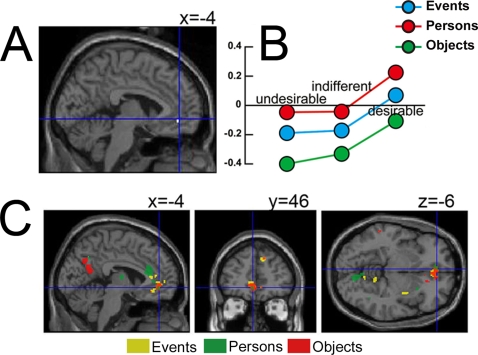
Conjunction analysis of desirable > undesirable (displayed at the threshold Puncorrected <0.001).Peak activity was located in superior orbito-frontal cortex (−4, 46, −6 SVC) and is shown in sagittal section (A). Parameter estimates for the three stimulus categories and for the three desirability classifications (B). A proximal voxel (−6, 46, −4, see Fig 6A) exhibits a linear relationship with desirability. Figure (C) shows the overlap in areas of cortex activated by each stimulus category (in red, green, and yellow) on sections through a template brain at −4, 46, −6.